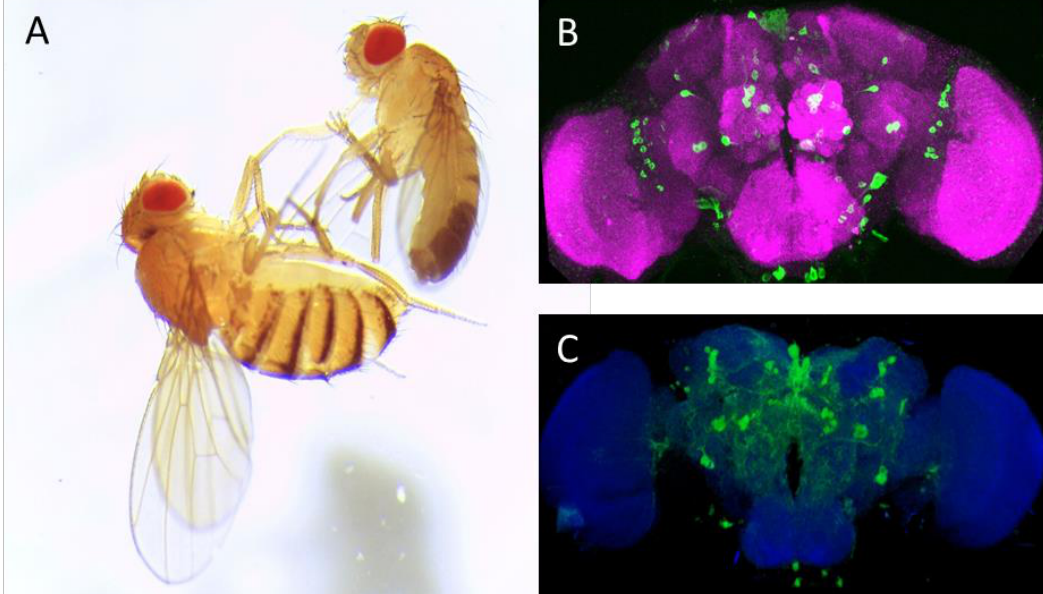
Figure 1. Drosophila melanogaster ( A ) and adult fly brain ( B , C ). ( A ): Image of adult female ( left ) and male ( right ) Canton-S Drosophila melanogaster ; ( B ): Anterior view of adult fly brain carrying serotonin transporter protein trap (Bloomington Drosophila Stock Center no. 60529, Bloomington, IN, USA). The cell bodies of serotonergic neurons are labeled in green by expression of GFP; and ( C ): Posterior view of TH Gal4; mCD8:GFP adult fly brain: The dopaminergic neurons are delineated by their expressing the murine GFP-tagged CD8, which uniformly labels the neuronal membrane. ImageJ 3D Viewer plugin was used to generate the image. Anti-neuronal cadherin antibody (MNCD2, DSHB, University of Iowa, IA, USA, magenta ( B ) and blue ( C )) was used to delineate the adult fly brain. Scale bar: 50 μm.